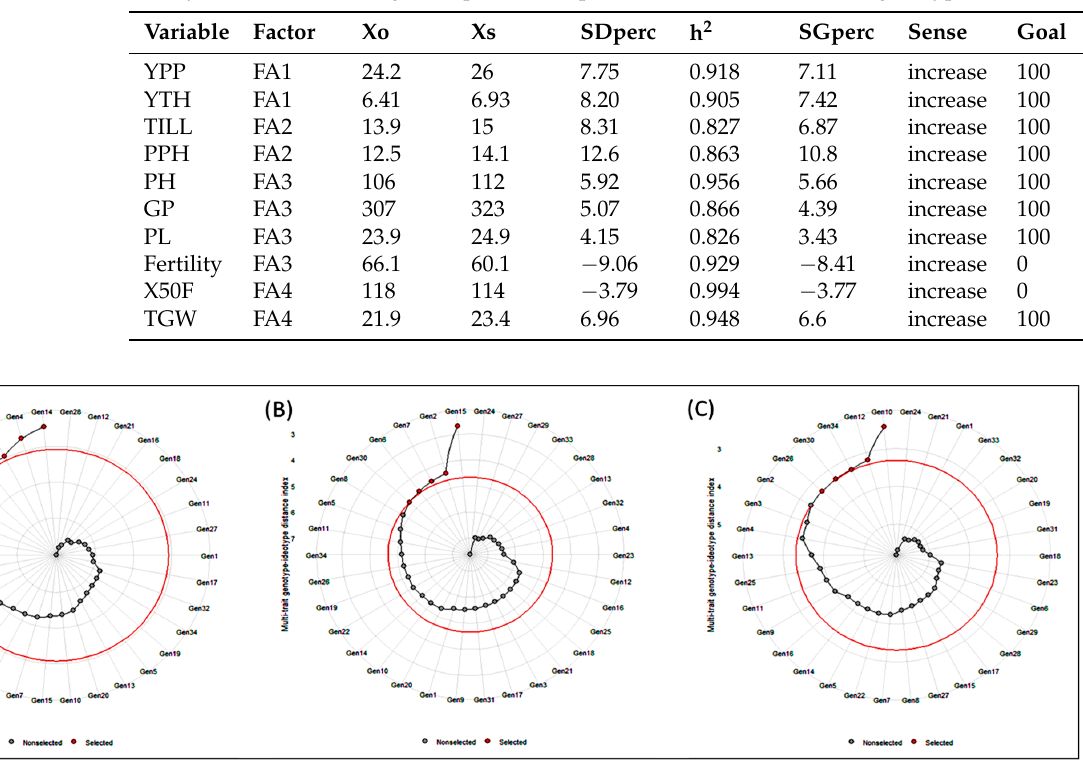
Figure 8. The circular preview indicates the ranking of genotypes based on the MGIDI selection index as well as the best rice genotypes with the associated locations ( A ) Satkhira, ( B ) Kushtia, and ( C ) Barishal. The selected ones are marked in red colour.